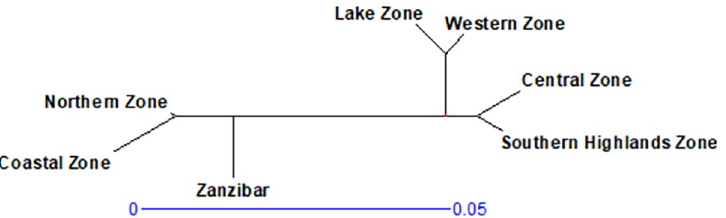
Fig 4. Relationship of geographical zones based on the genetic distance of 401 cassava landraces collected therein. Nei’s genetic distance was calculated among Zones, and the relationships displayed using the unweighted neighbour- joining method in Darwin v5.0